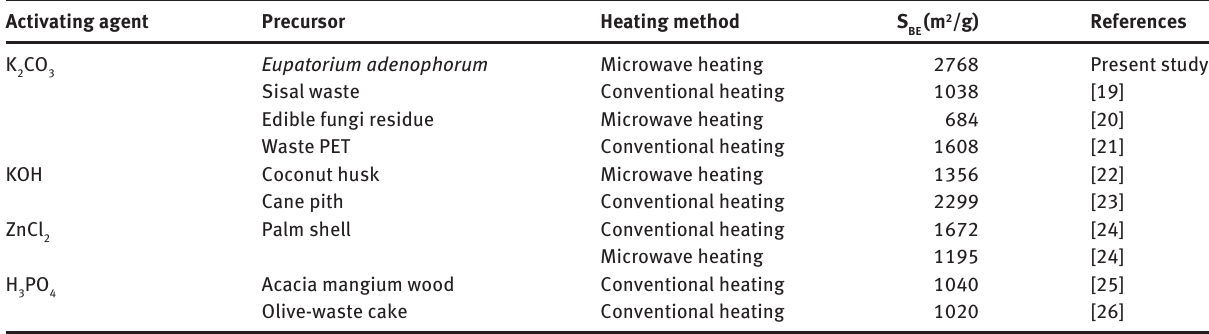
Table 3: Comparison surface area of activated carbon with different activation agent. Activating agent